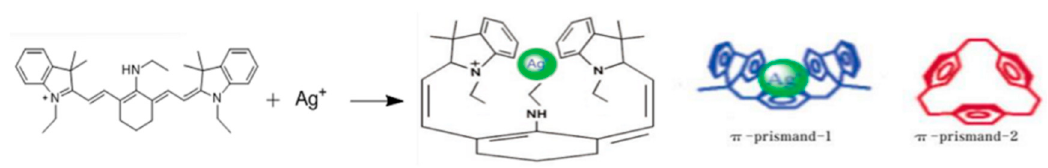
Figure 10. Proposed binding modes of QCy and Ag + , and a similar structure of the π‐ prismand.